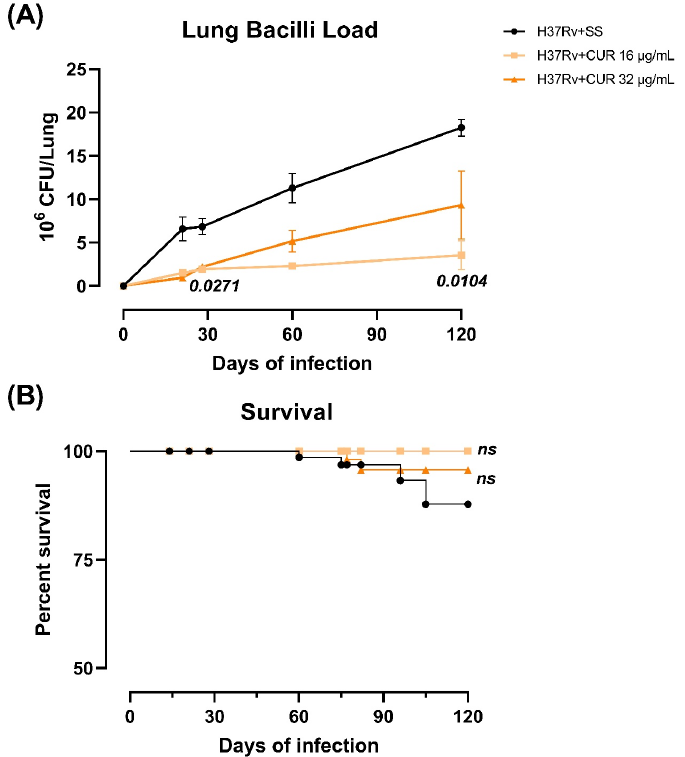
Figure 1. The effect of curcumin (CUR) therapy (16 or 32 µ g/mL) given early in the TB infection (14 days post-infection) on the progression of lung disease in intratracheal infected mice with 2.5 × 10 5 Mtb colony-forming units (CFU) virulent strain H37Rv. ( A ) Bacillary burdens in the lungs of TB mice treated with CUR and control mice who only received saline solution (SS) as the vehicle. F (1.221, 2.442) = 21.66, p = 0.0287, two-way analysis of variance (ANOVA). Tukey’s multiple compar- isons test. ( B ) Survival rates of control mice given SS versus CUR-treated animals ( n = 36). p = 0.2464, logrank test for trend. Data are presented as mean ± SEM. Both doses of CUR significantly decreased the bacterial load in the lung from day 21 post-infection and tended to increase the survival rate. However, the 16 µ g/mL dose was more effective in decreasing lung disease than the 32 µ g/mL dose. CUR administration in both doses is safe to administer in animals infected with Mtb , as they do not aggravate lung disease and have a beneficial effect.